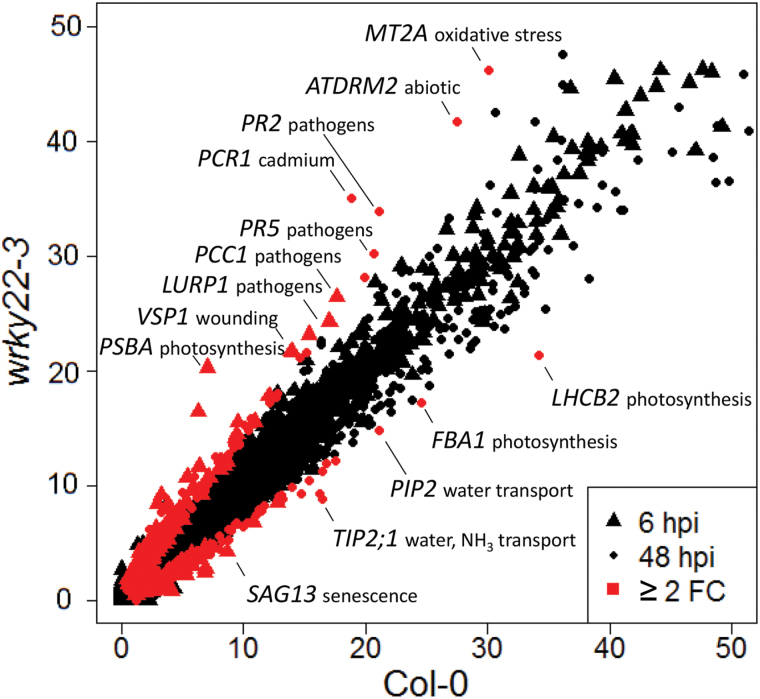
Gene transcripts of aphid-infested wild-type and wrky22-3 plants. Differentially expressed genes between wild-type and knockout plants (≥2-fold change) are shown in red. Axes depict the square-root transformation of the normalized number of transcripts (the number of fragments per kilobase of transcript per million reads mapped (FPKM)); genes ≤2500 FPKM are shown (including all DE genes in the dataset). Annotations include gene name and biological process; wounding: wound responsive; pathogens: pathogen responsive; cadmium: responsive to cadmium; abiotic: responsive to several abiotic stresses.